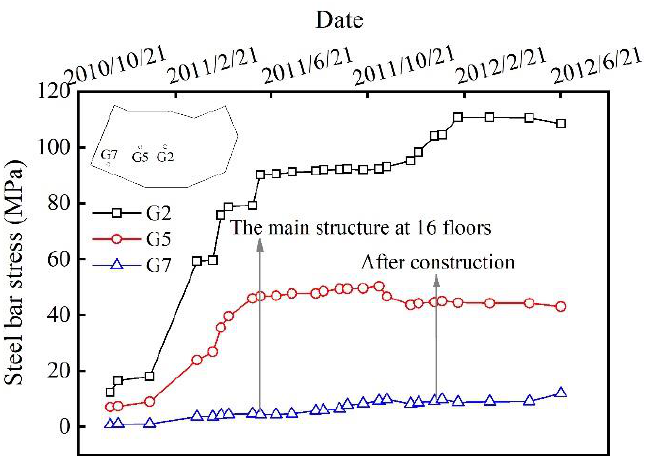
Figure 23. Curve of steel bar stress variation with time .